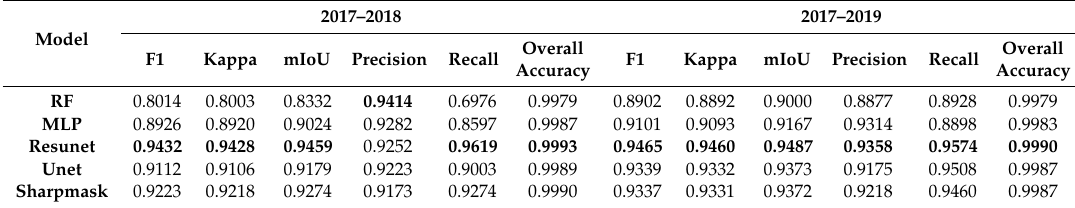
Table 3. Performance measures for the model validation results for the 2017–2018 and 2018–2019 sequences. Best results in the column in bold text.